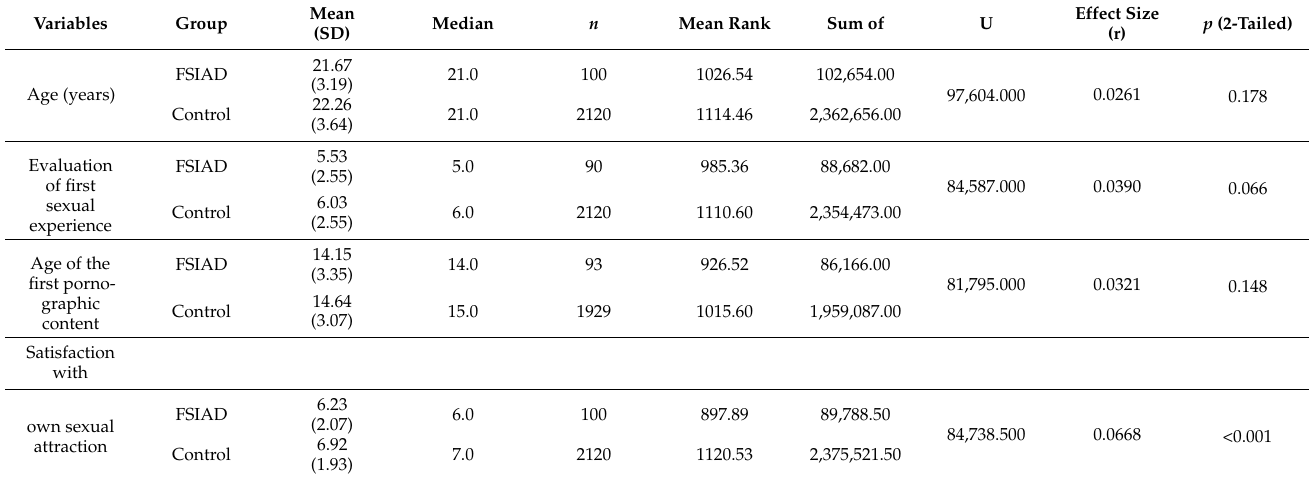
Table 3. Differences between the FSIAD group and control group in sexual experience, age of first pornographic content, and